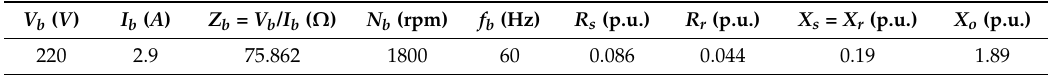
Table A1. The data of the machine under